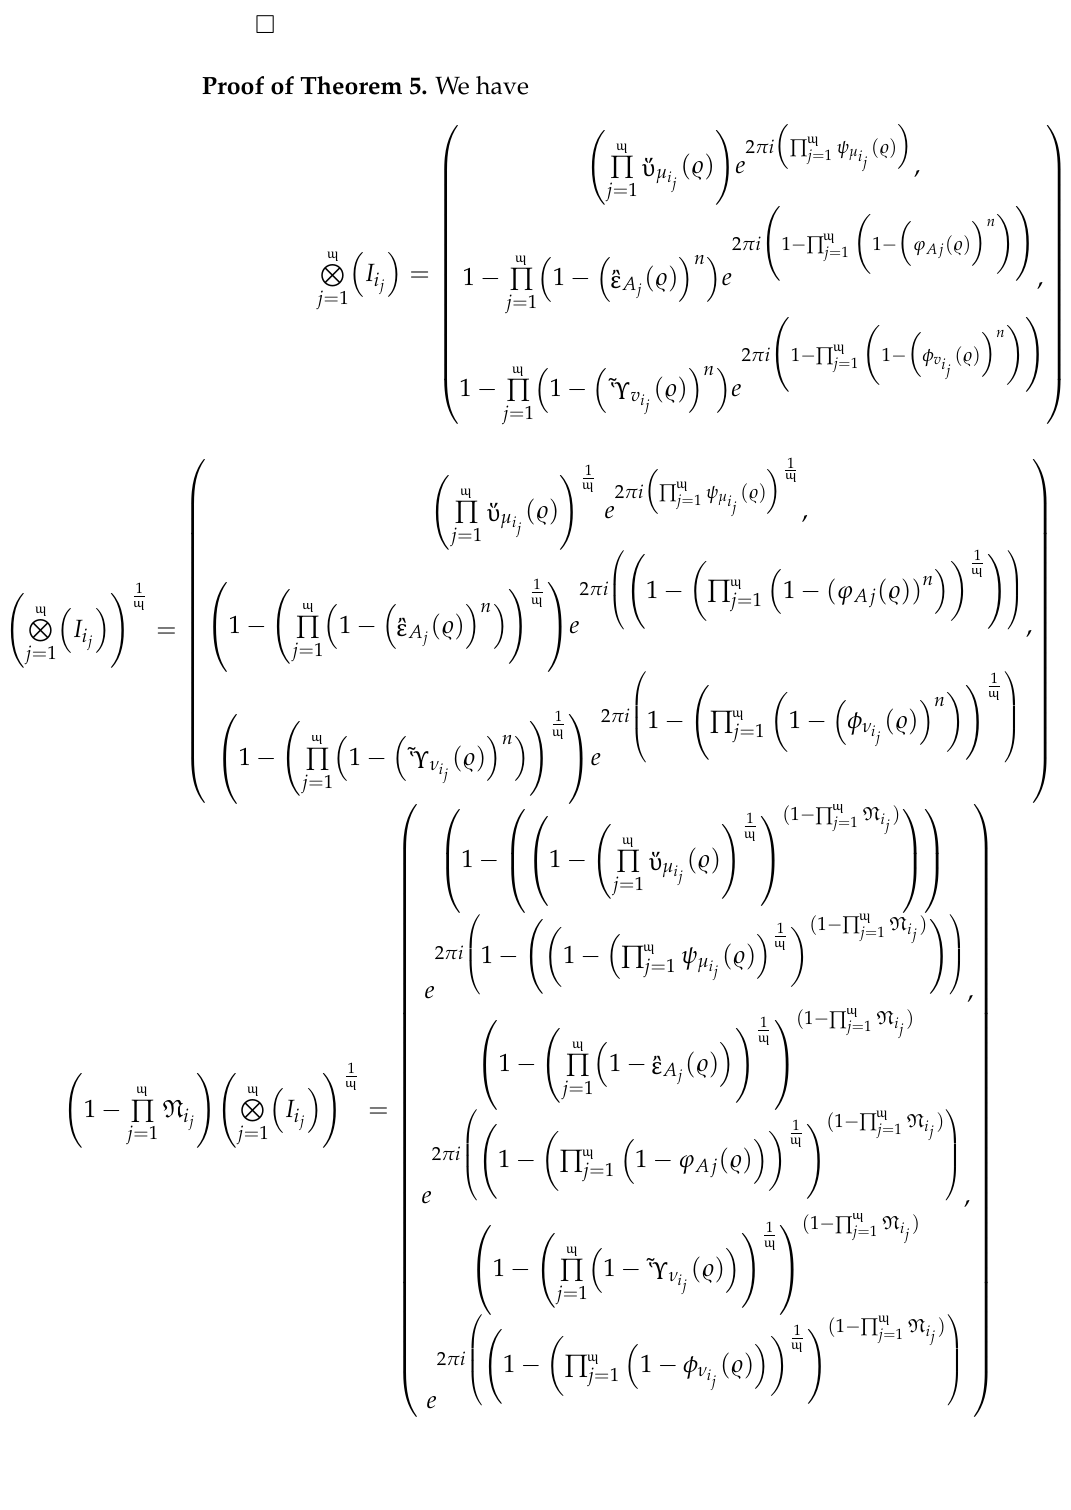
Table 1. Symbols and their meanings.